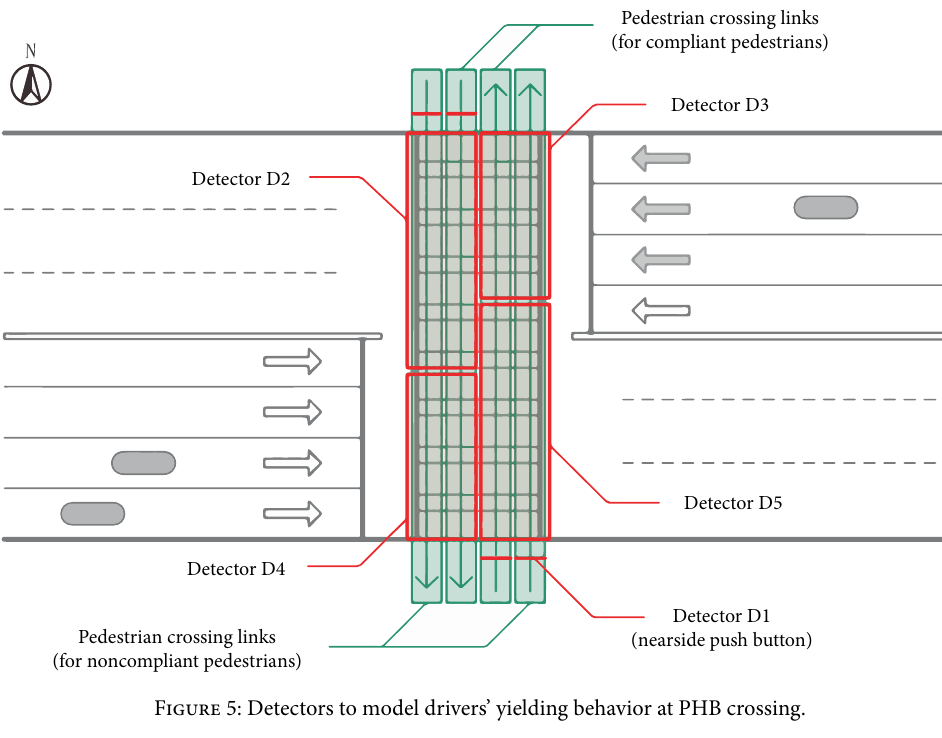
Figure 5: Detectors to model drivers’ yielding behavior at PHB crossing.